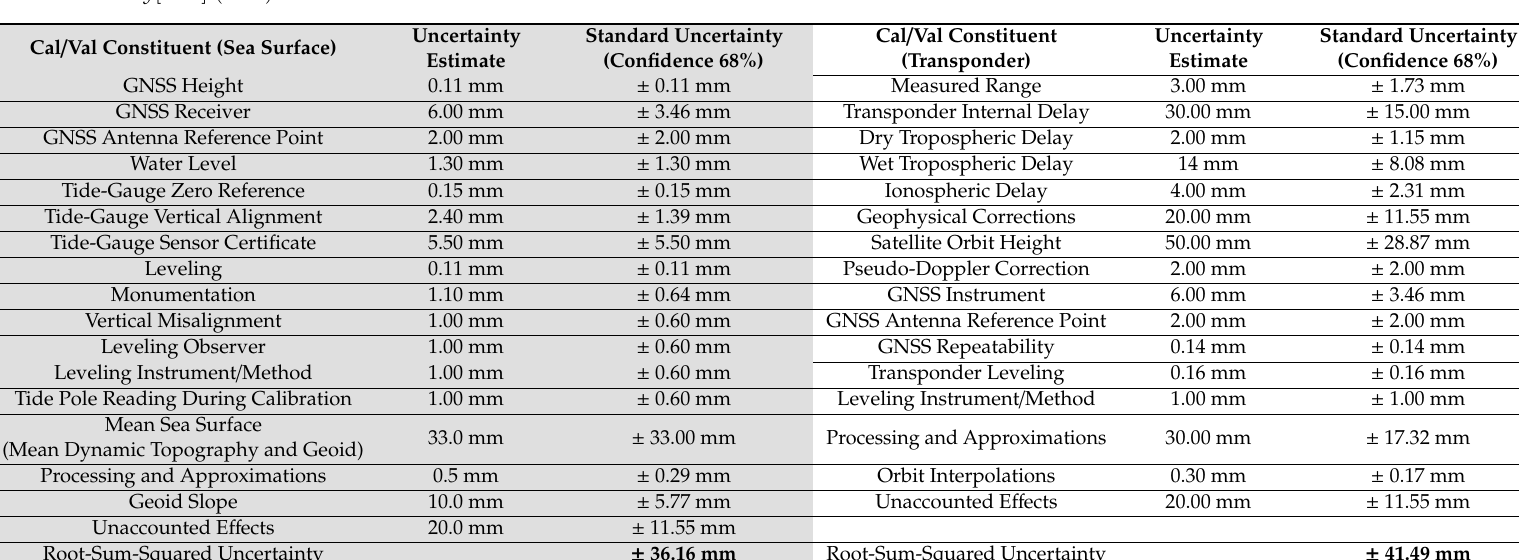
Table 3. Examples of how uncertainties should be calculated following the fiducial reference measurements strategy and the guide for expressing uncertainties. The left table refers to sea-surface calibration and the right table corresponds to transponder calibration. The final standardized uncertainty (at 68% confidence level) based on a sea-surface Cal / Val procedure, described in terms of a Root-Sum-Square value, has been computed as for example, for the left three columns of table as Cal/Val Uncertainty [ mm ] ( 68% ) = ± 36.16